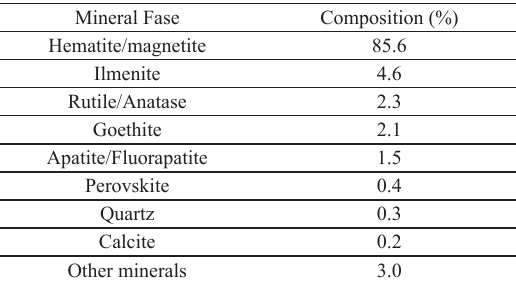
Table 2. Mineralogical composition of magnetic tailings by